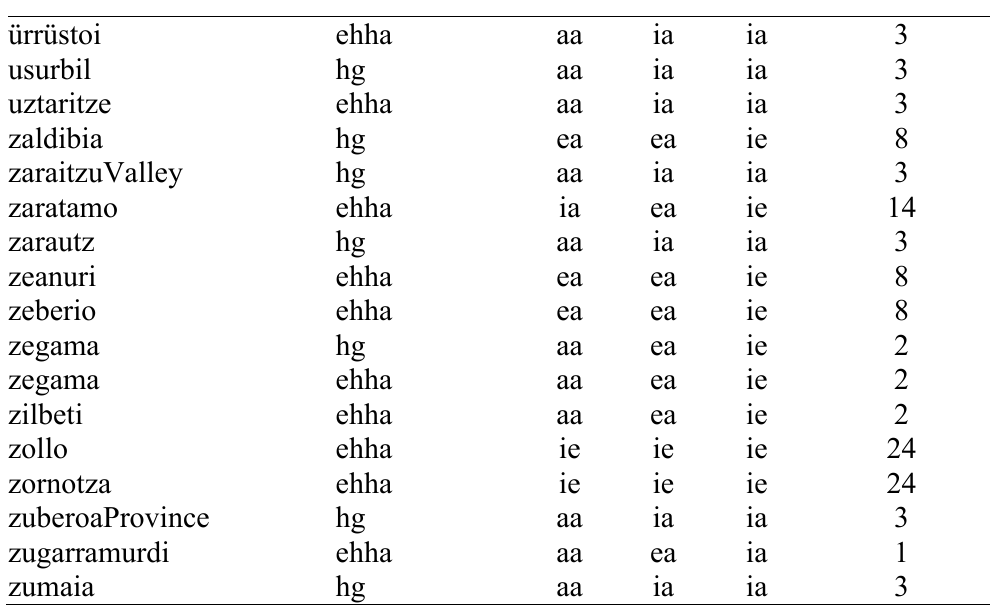
Table 11 . Summary of all the combinations attested in EHHA and